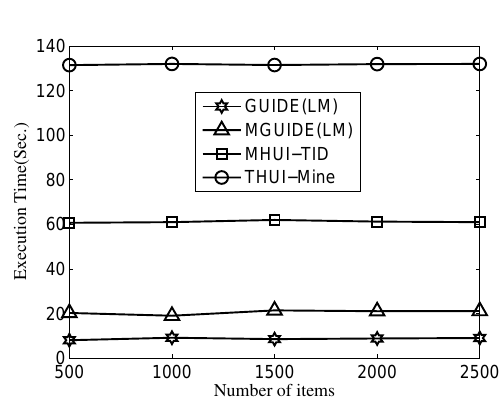
Fig. 7. Execution time vs. Number of